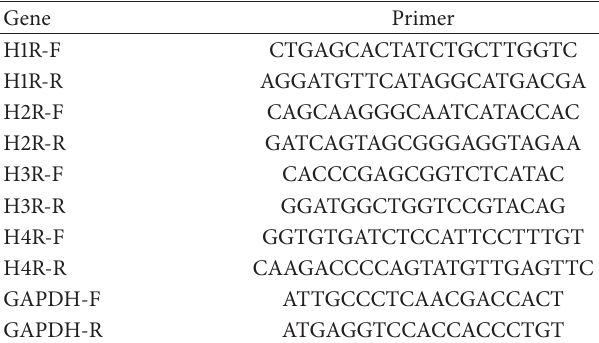
Table 1: Primer sequences used in